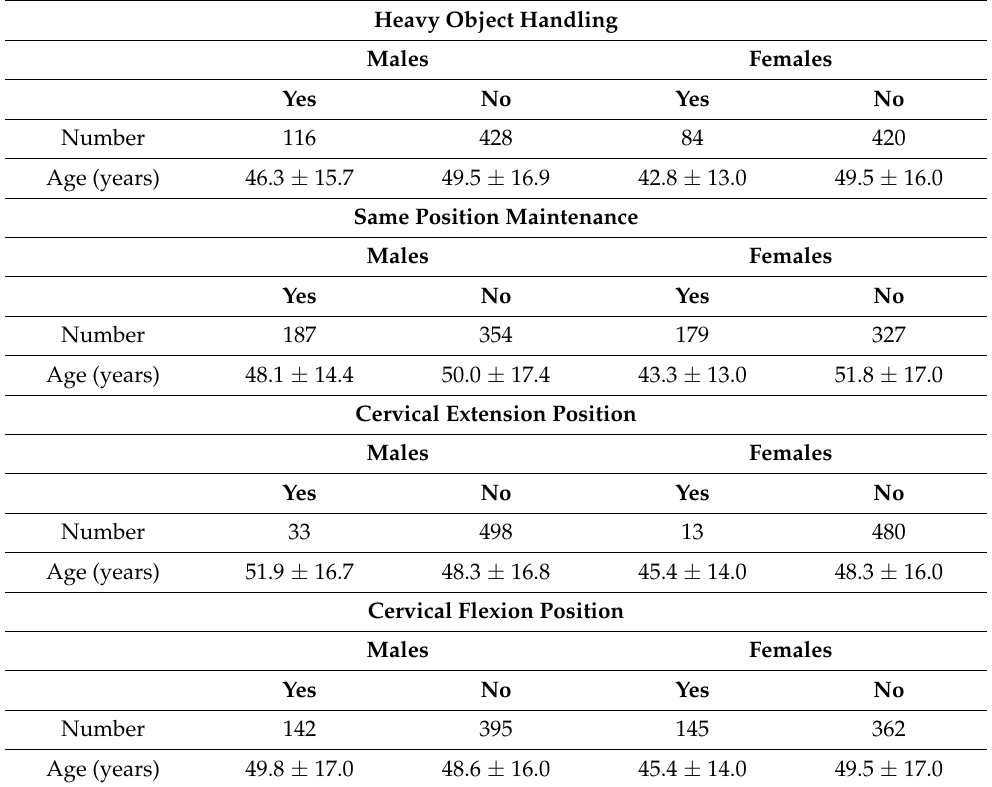
Table 3. The detail of four labor types between males and